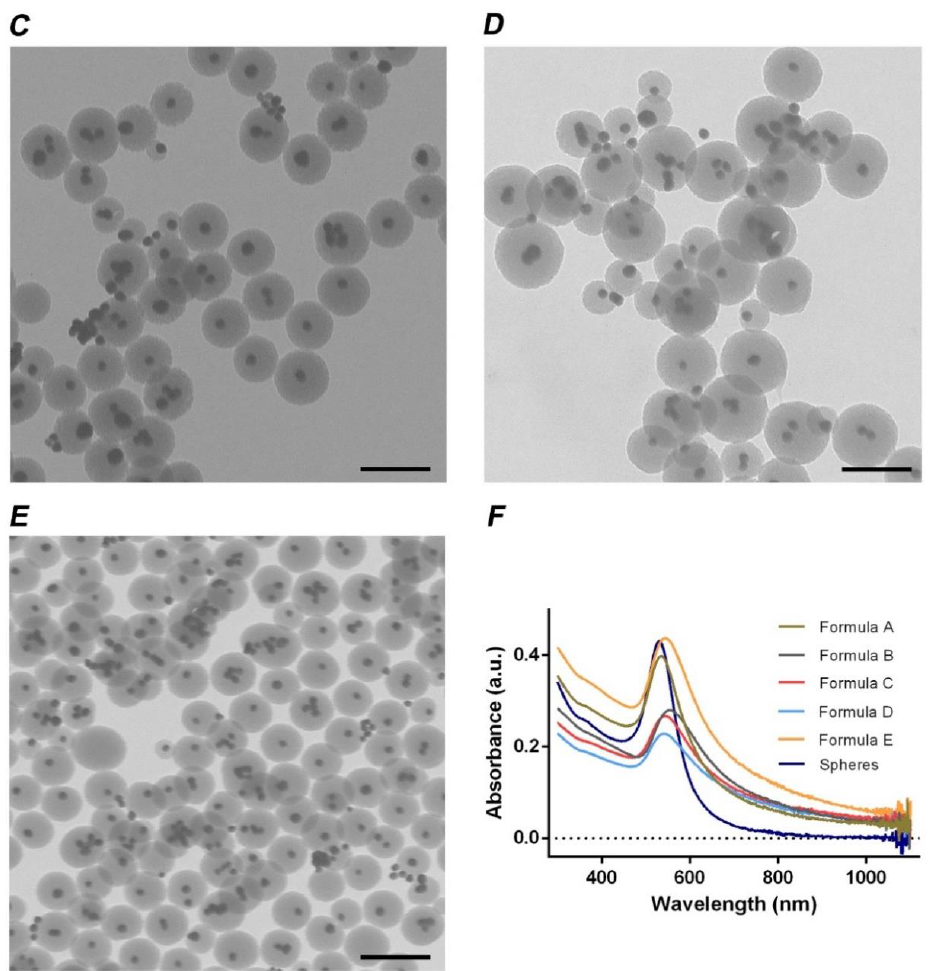
Figure 2. AuMSS nanoclusters morphology and UV-Vis-NIR data analysis. ( A ) TEM images of Formula A; ( B ) Formula B; ( C ) Formula C; ( D ) Formula D and ( E ) Formula E AuMSS nanoclusters. ( F ) UV-Vis-NIR spectra of different nanoformulations of AuMSS nanoclusters. Scale bar: 200 nm.